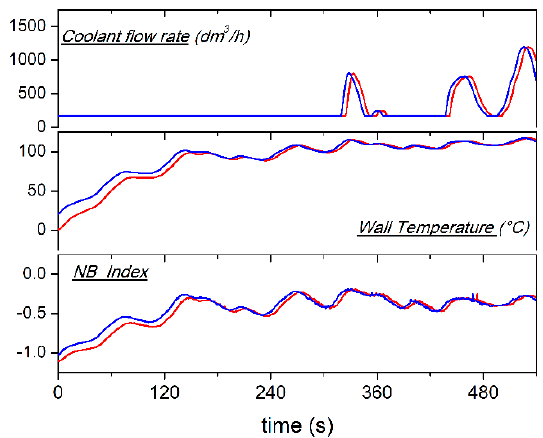
Figure 21. Controlled coolant flow rate ( top ), average wall temperature ( middle ) and NB_Index ( bottom ) during the NEDC cycle starting from 20 °C (red line) and 0 °C (blue line) environment.